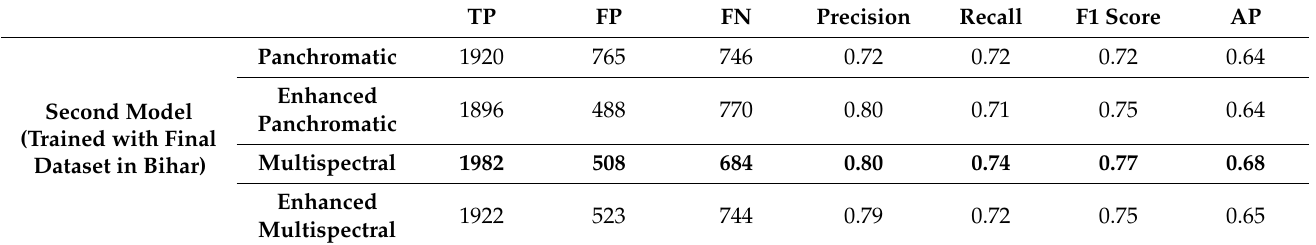
Table 7. Delineation accuracy of mapping smallholder field boundaries in Uttar Pradesh with models trained using WV-3 data in Bihar. The accuracy metrics from the model with the best F1 score and AP values are highlighted in bold.